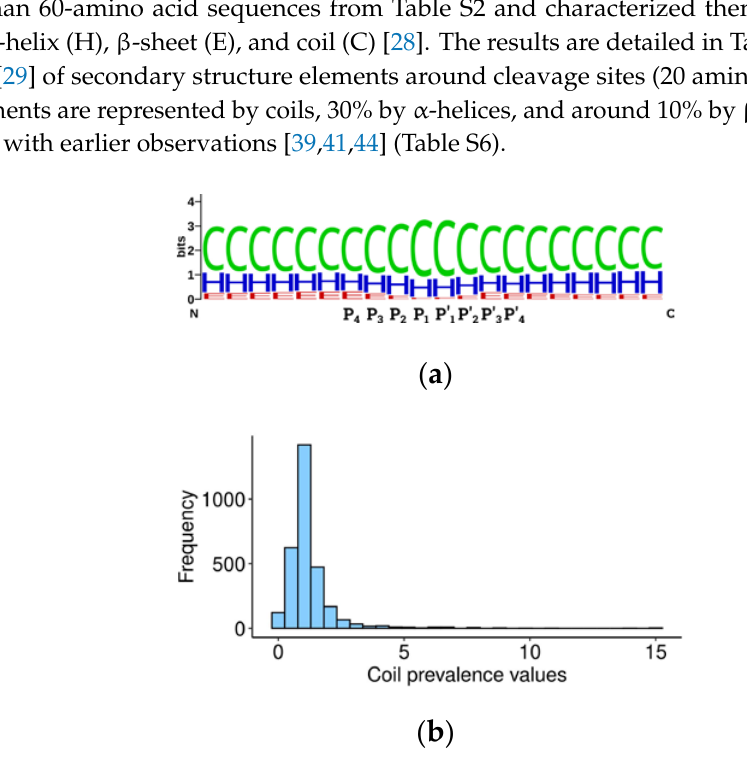
Figure 2. Secondary structure of the human caspase cleavage site surroundings. ( a ) Weblogo representation of the frequency of secondary structure elements surrounding the cleavage site (positions P4-P4’). One stack of letters corresponds to one amino acid. Secondary structure elements are abbreviated as follows: C: coils, H: helices, E: beta-strands. ( b ) Distribution of coil prevalence values of human caspase cleavage sites, calculated as described in the text.